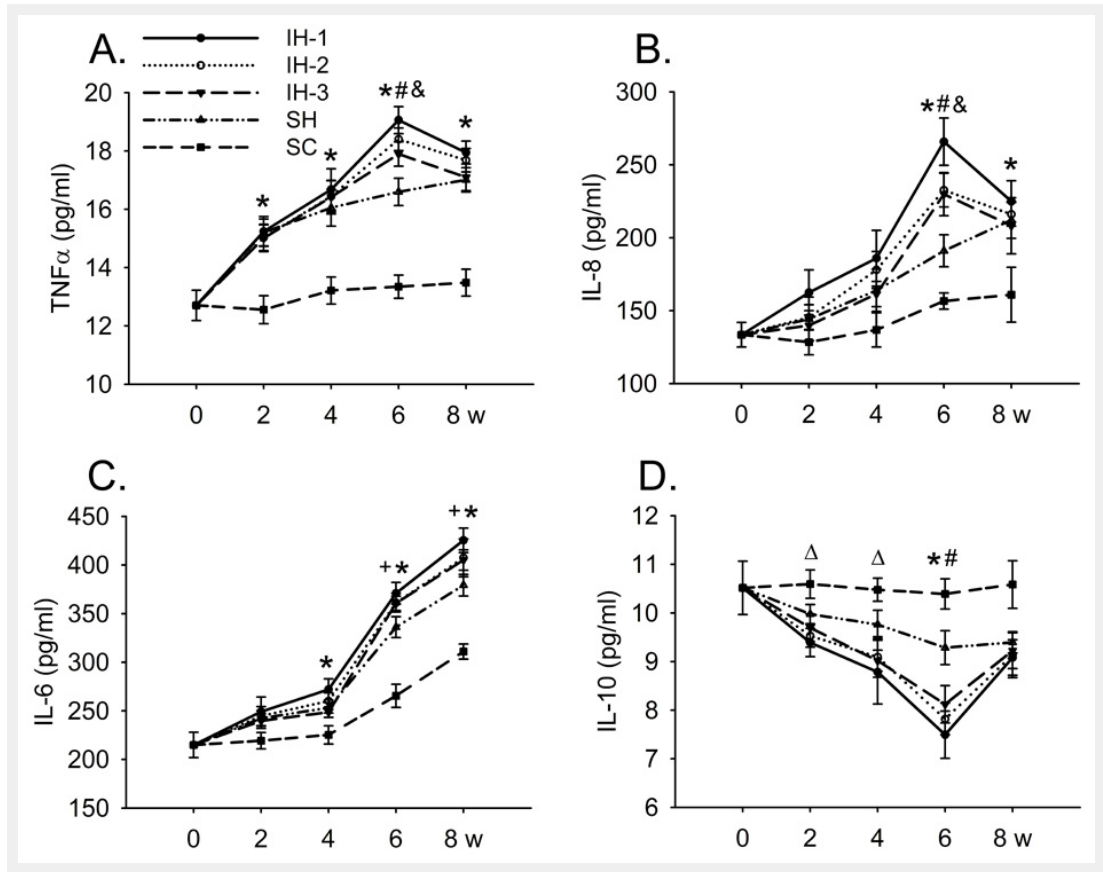
Figure 2 Time course of inflammatory cytokine levels in serum. Serum levels of TNF-α (A), IL-8 (B), IL-6 (C), and IL-10 (D) were measured in the IH1 (n = 7), IH2 (n = 8), IH3 (n = 8), SH (n = 8) and SC group (n = 8) at each time point. The data were plotted as mean ± SE. Results of two-way ANOVA statistical analyses were labeled. * P <0.05 IH1, 2, 3 and SH groups vs the SC group; # P <0.05 IH 1, 2, 3 vs the SH group; & P <0.05 IH1 vs IH3 group; + P <0.05 IH1 vs SH group; ∆ P <0.05 IH1, 2 and 3 vs SC